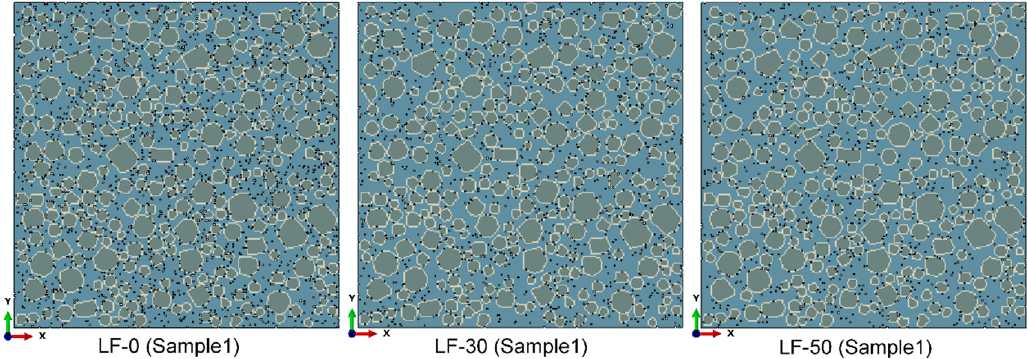
Figure 6. The numerical mortar specimens of LF-0, LF-30, and LF-50; the brilliant blue entity is the mortar matrix, the brown entities are the aggregate, the white entities are the ITZ, and the black vacancies are the pores.